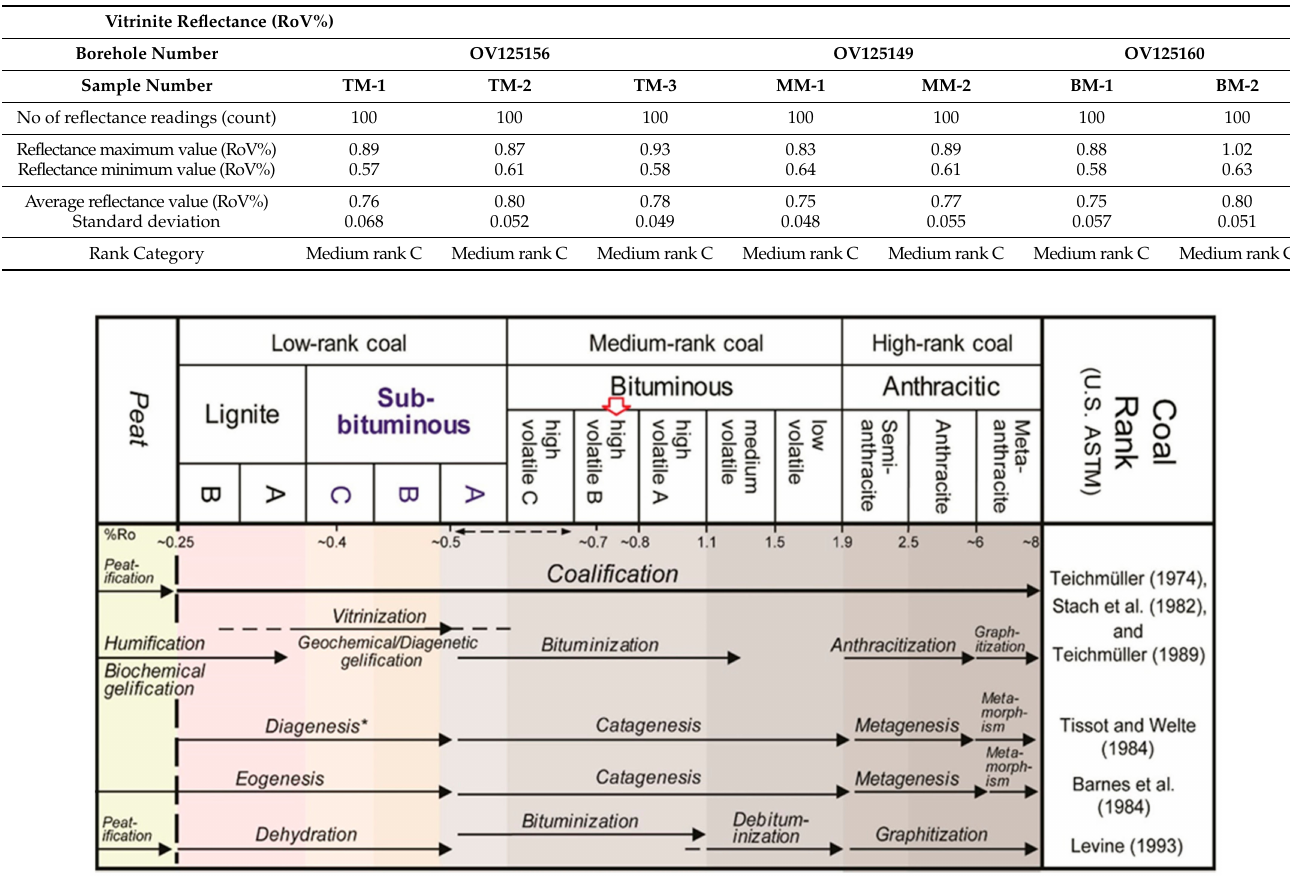
Figure 10. Position of the analyzed samples in the Coal Classification of the Economic Commission for Europe (UN-ECE) in coal classification